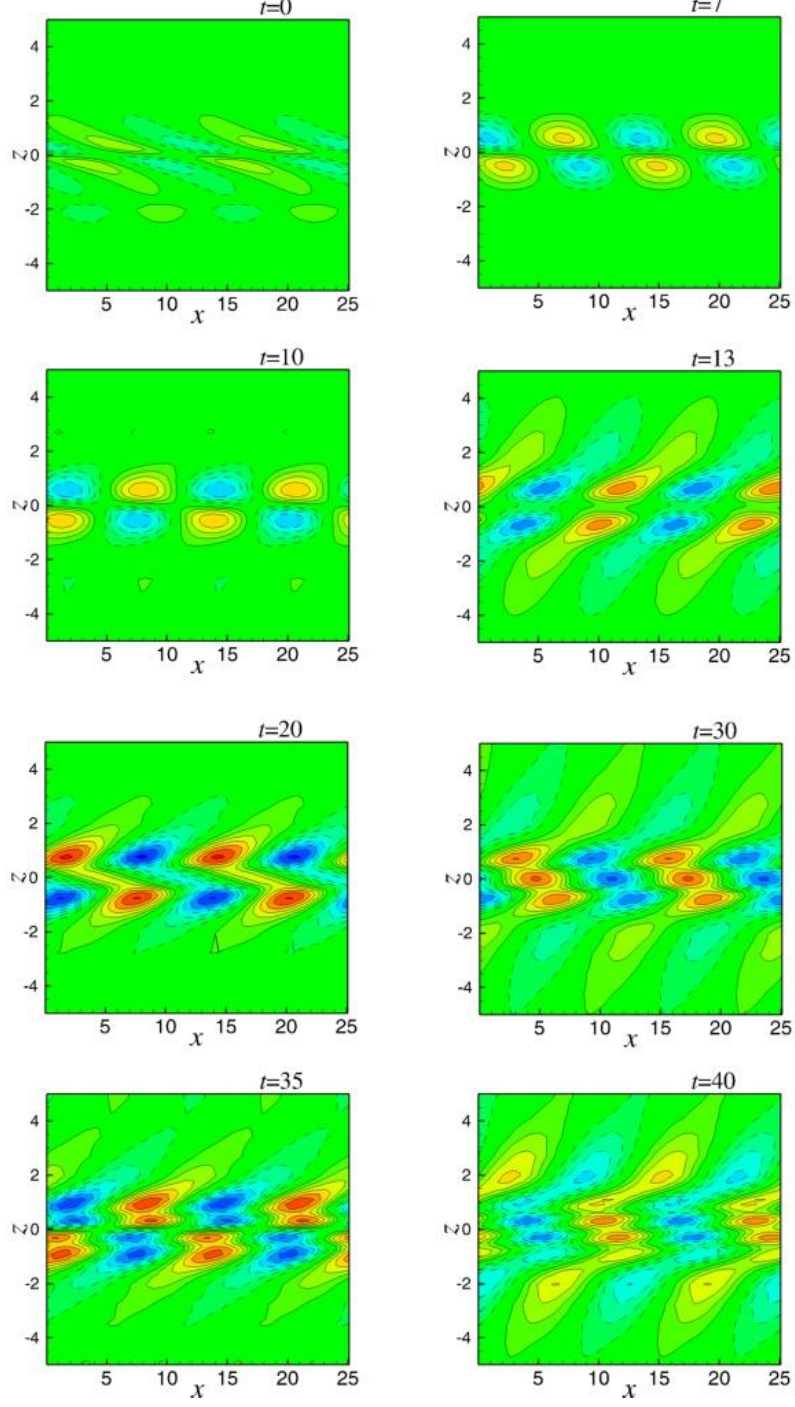
Figure 3. Evolution of the streamwise velocity component, u , of a two-dimensional optimal vector calculated for the maximal growth at t max = 10. Ri = 1, Re = 1000, α = 0.5, β = 0. Solid and dashed lines represent positive and negative values of u . The plotted values are equally spaced between −2 and 2.